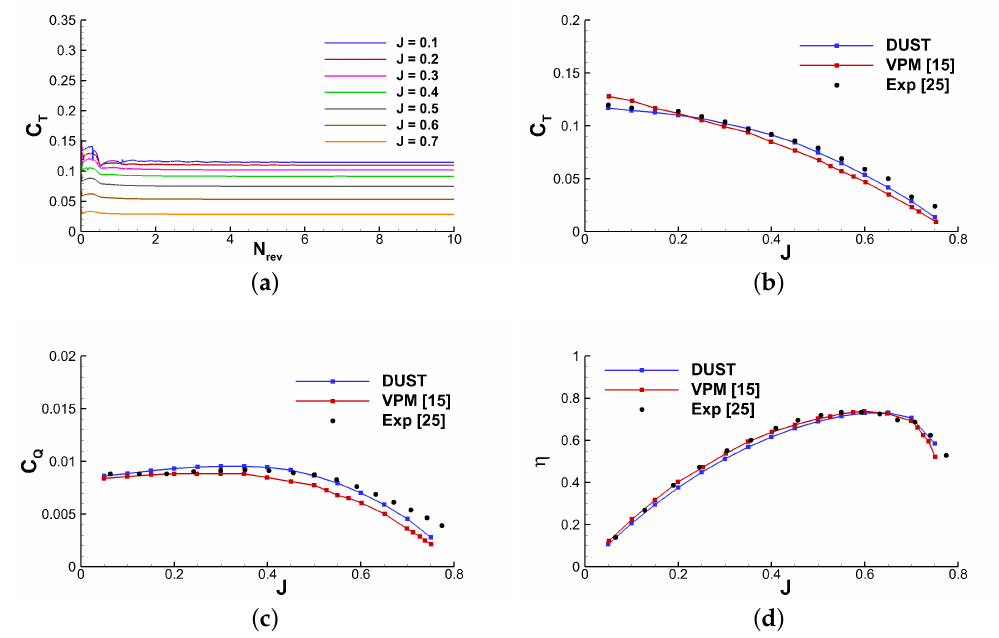
Figure 2. Comparison of the results obtained for the APC 10 × 7 propeller, Re D = 1.5 × 10 6 , M t = 0.36. ( a ) Time histories of the thrust coefficient C T calculated by DUST as a function of the number of rotor revolutions N rev ; ( b – d ) comparison of the DUST simulations results with the experimental data from McCrink and Gregory [24] and the numerical simulations results from Alvarez and Ning